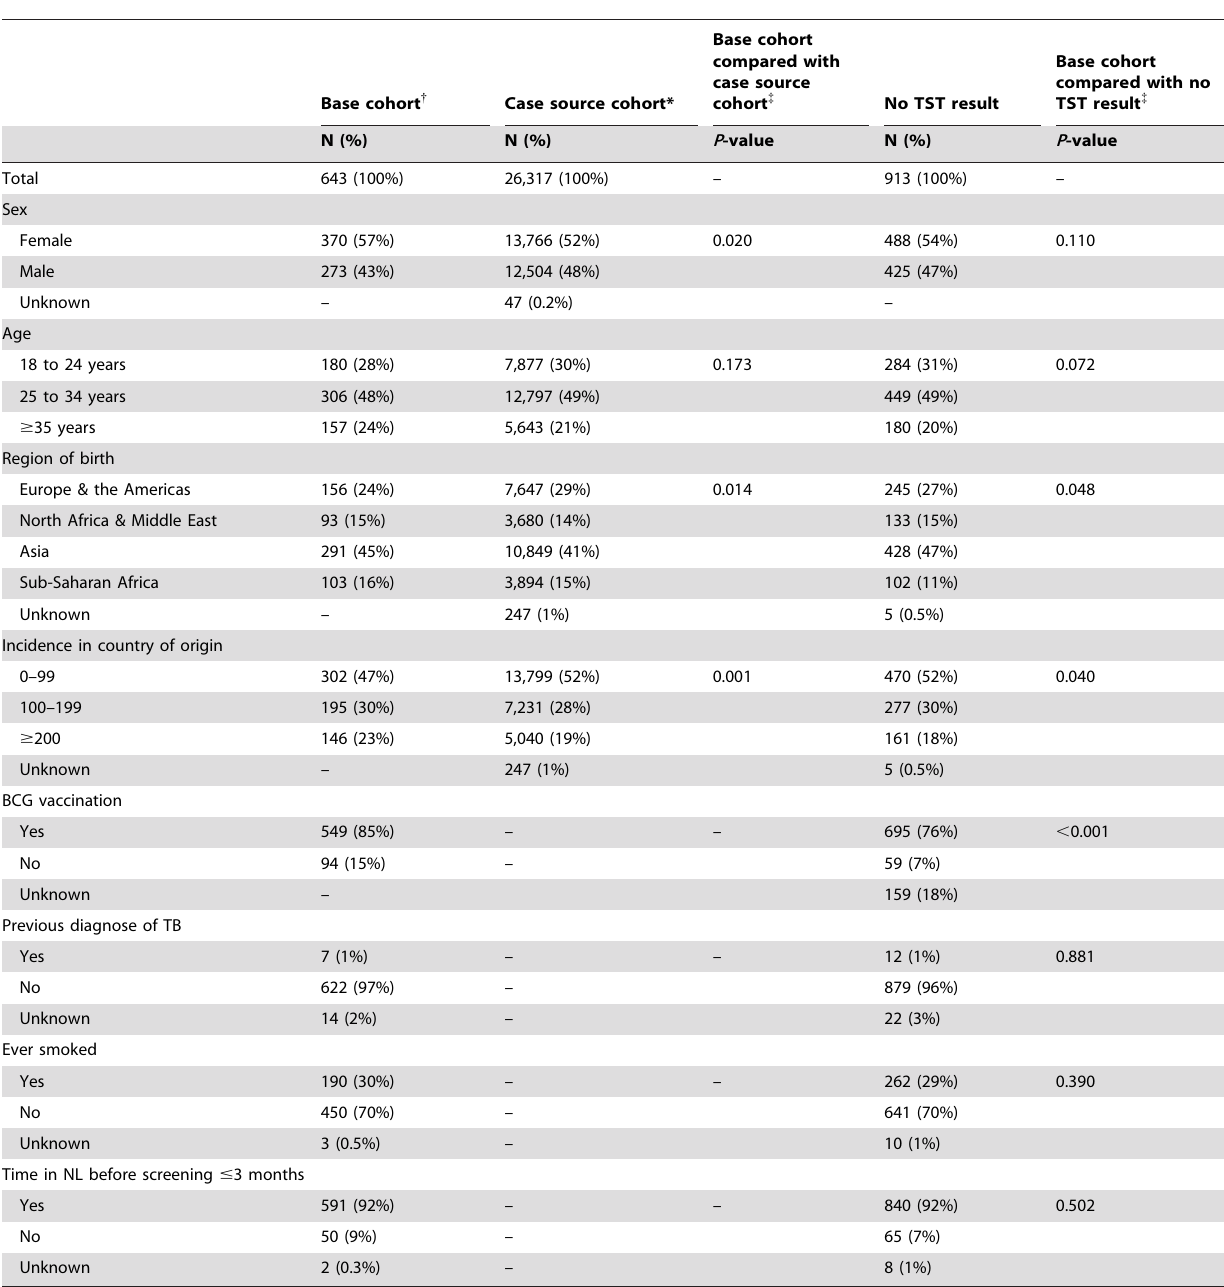
Table 1. Baseline characteristics for base cohort, case source cohort and participants without TST